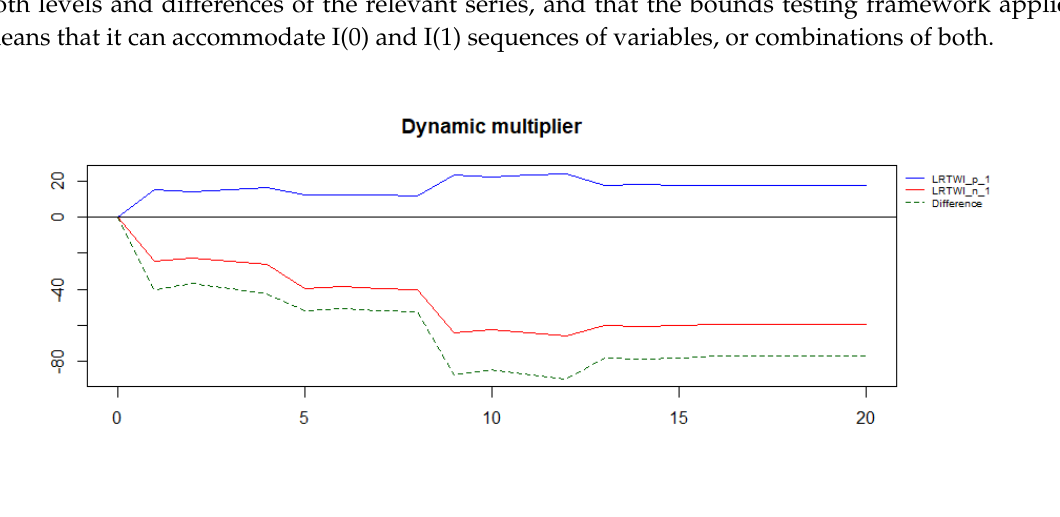
Figure 4. Dynamic